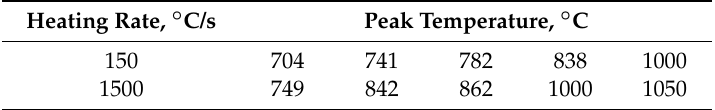
Table 2. Summary of measured peak